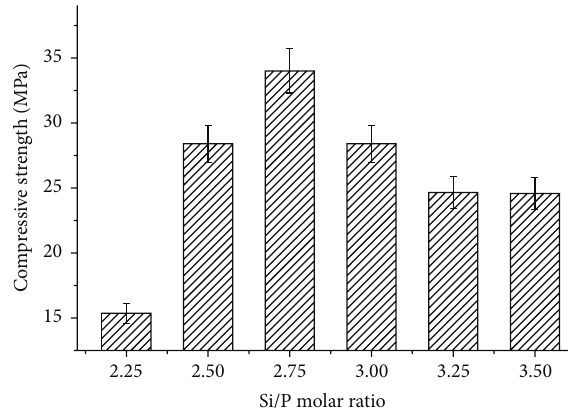
Figure 4: Infrared spectra of calcined Medenine clay at 700 ∘ C, phosphoric acid 85%, aluminum phosphate, and geopolymers at different molars ratios Si/P(G 𝑥 ). (a) AlPO 4 , (b) AP (85%), (c) calcined clay 700 ∘ C, (d) G 3.5 , (e) G 3.25 , (f) G 3 , (g) G 2.75 , (h) G 2.5 , and (i) G 2.25 .